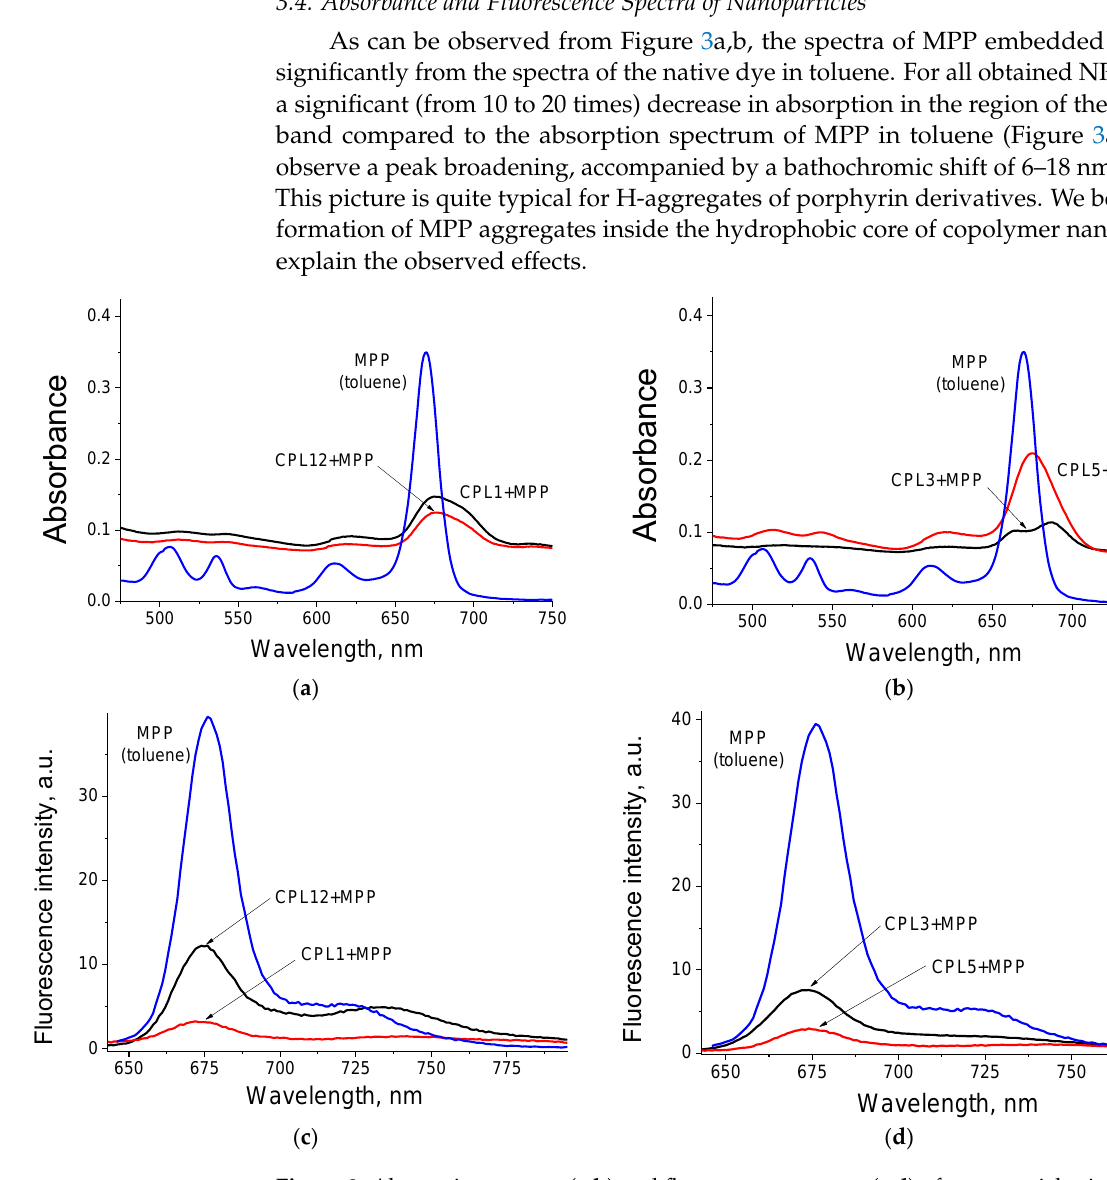
Table 2. A comparison of photophysical properties and photodynamic activity of reference PS and